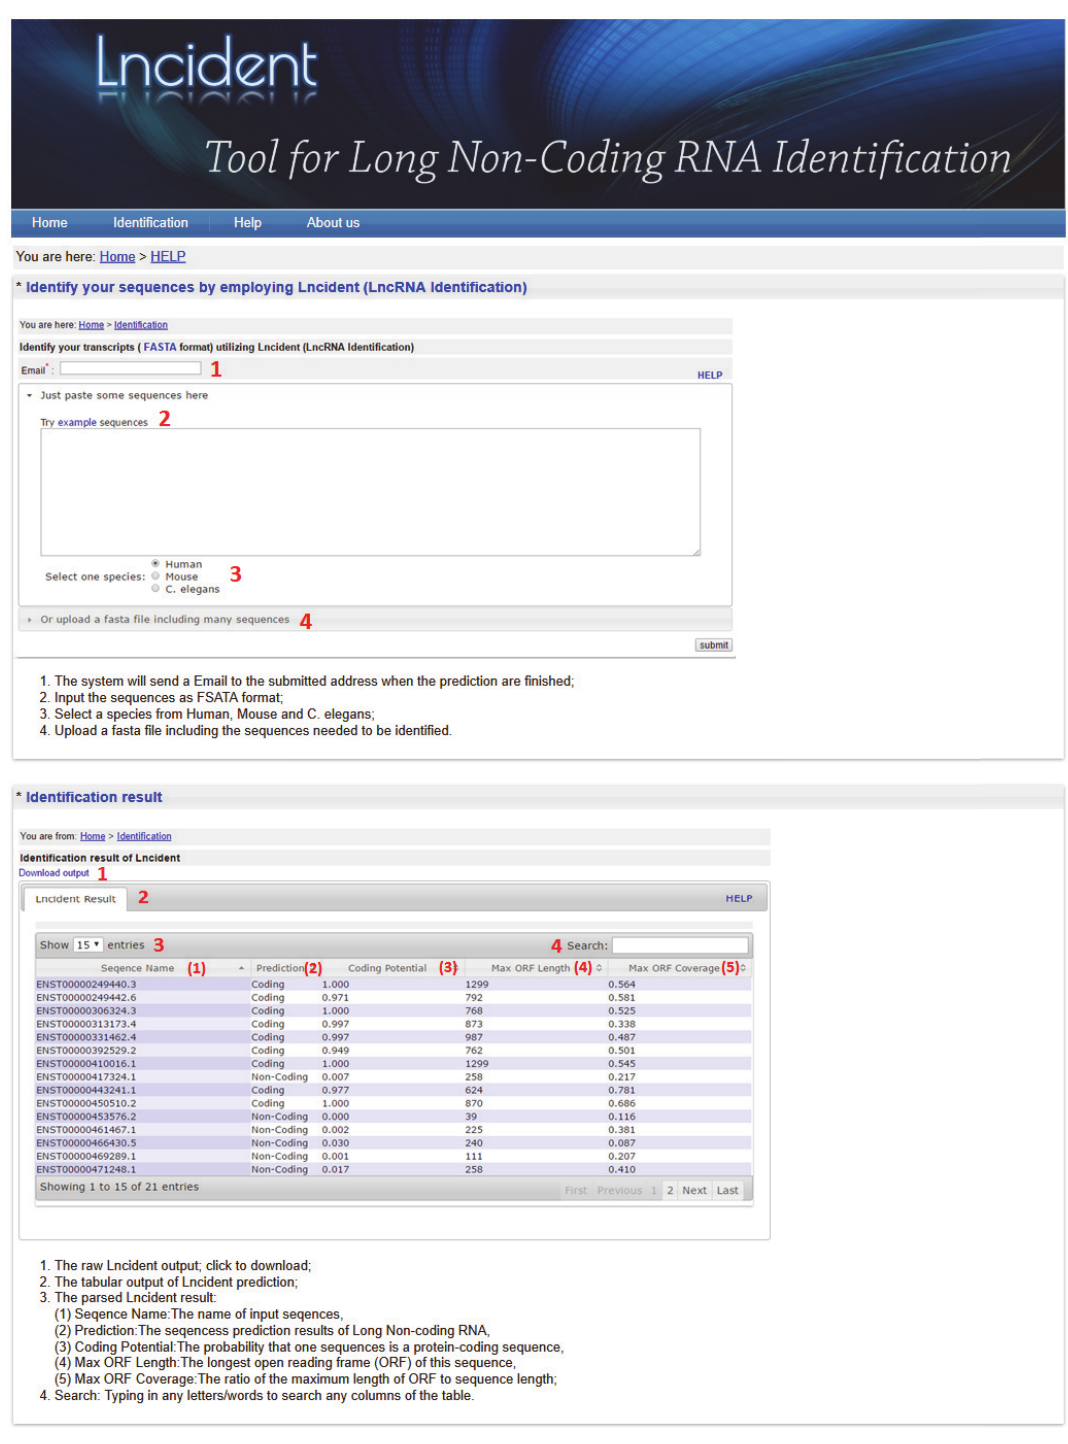
Figure 5: The screenshots of Lncident input and